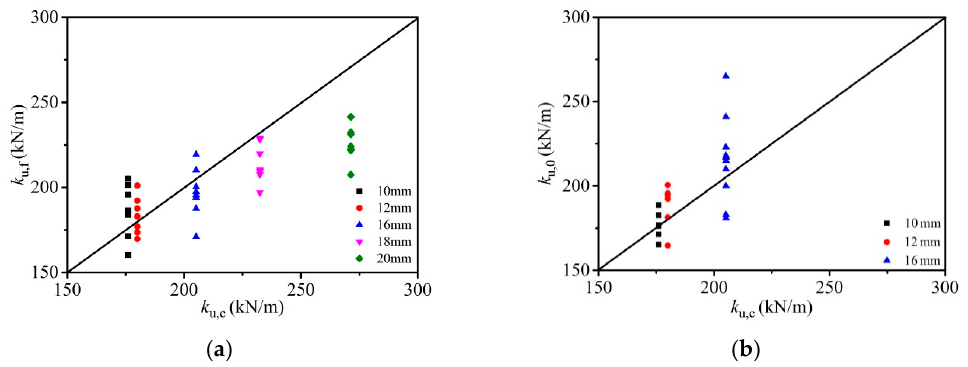
Figure 13. Comparison of predicted bond stiffness with the FE example results and the test results: ( a ) comparison of predicted bond stiffness with the FE example results; ( b ) comparison of predicted bond stiffness with the test results.